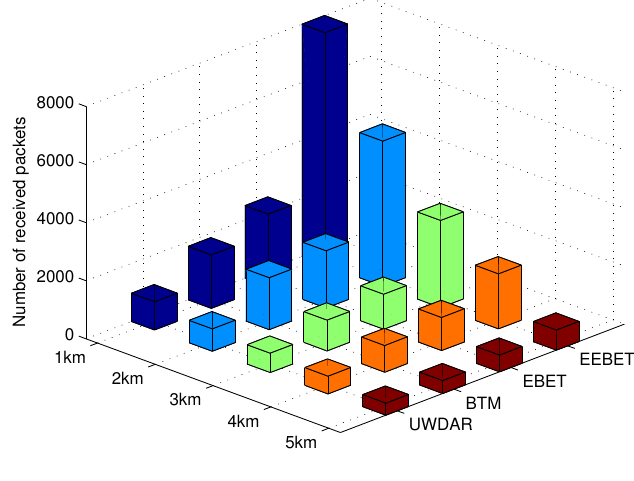
Figure 10. Comparison of throughput at differen network